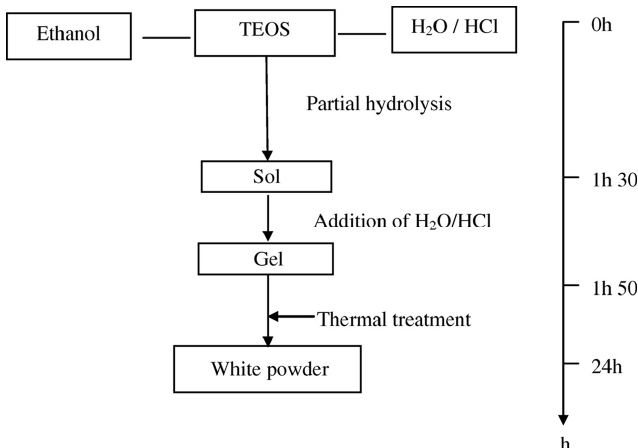
Figure 8. Preparation of SiO 2 powder by the sol-gel method [154]. Reproduced with permission from [154].